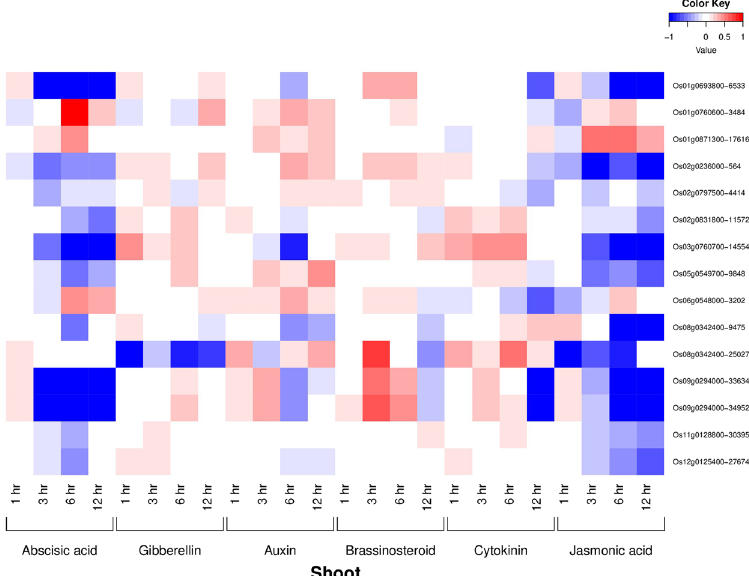
Figure 4. Heatmap representing the AbSR – ThrMPG and their phytohormonal expression profiling in shoot which are differentially expressed across the entire growth in the field conditions. Red color - up regulation; Blue color - down regulation; White color - unchanged. The colored scale bar at right side top represents the relative expression value, where -1 and 1 represent down and up regulation of AbSR – ThrMPG.